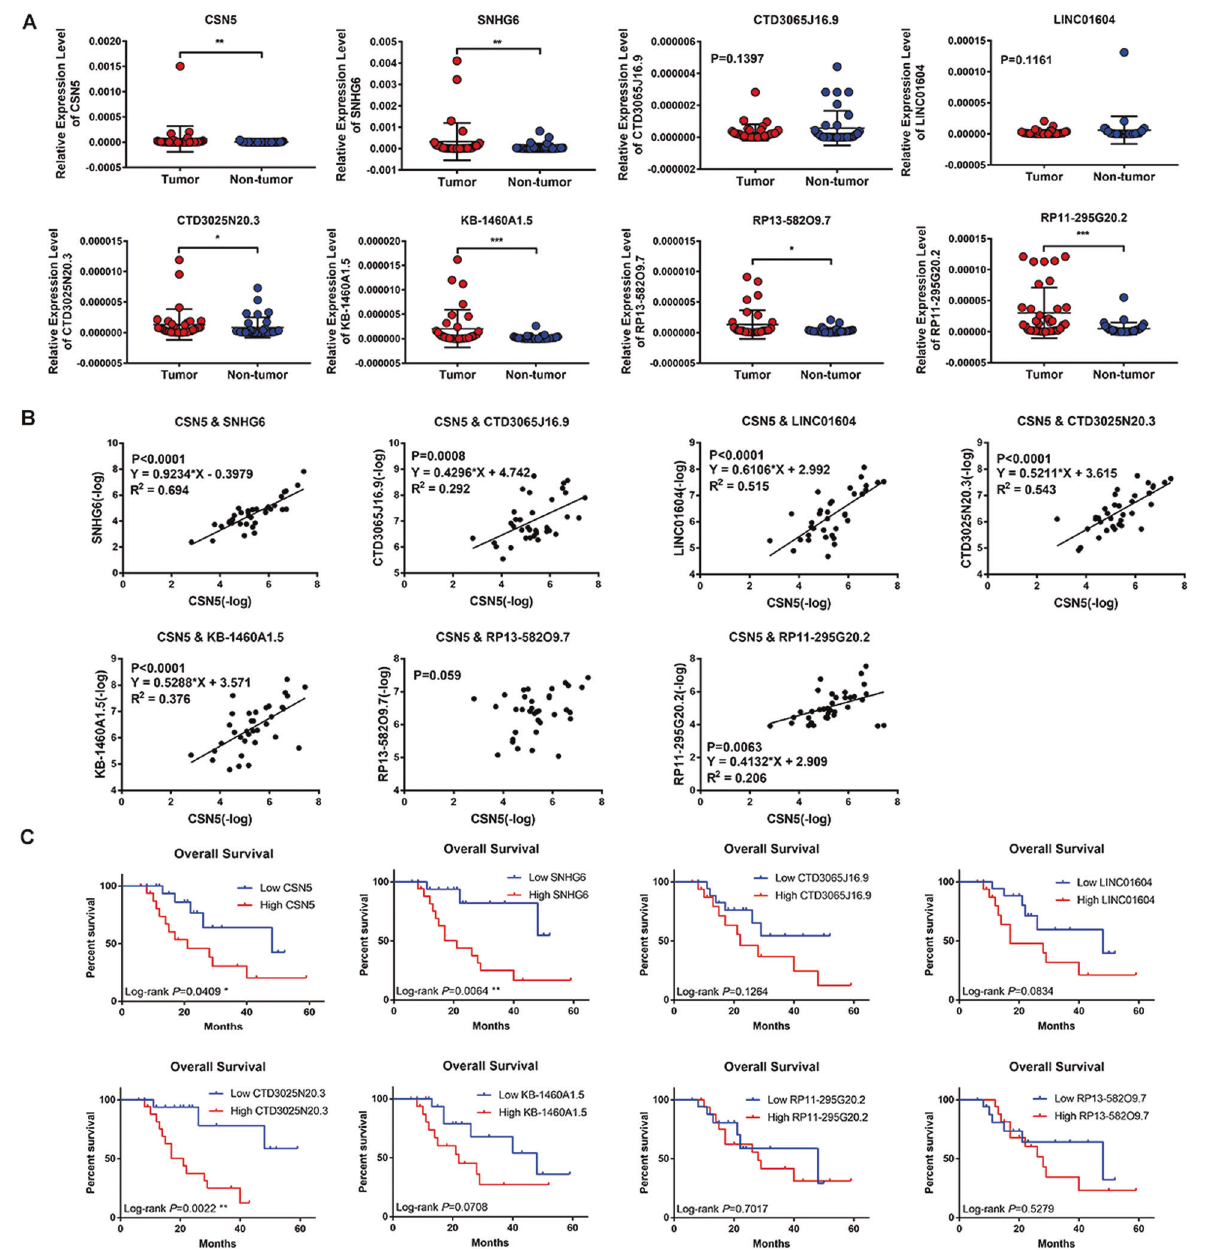
Fig. 4 The relative expression level of CSN5 and seven lncRNAs from the Zhongnan cohort. A The CSN5 and seven lncRNAs expression levels were signi fi cantly higher than in adjacent non-tumor liver tissues. * P < 0.05, ** P < 0.01. B The linear regression plots between the relative expression level in each of the CSN5 and seven-lncRNAs. The relative expression levels were normalized by the value of − log. C The prognostic value of CSN5 and seven lncRNAs of overall survival (OS) among the patients. * P < 0.05, ** P <